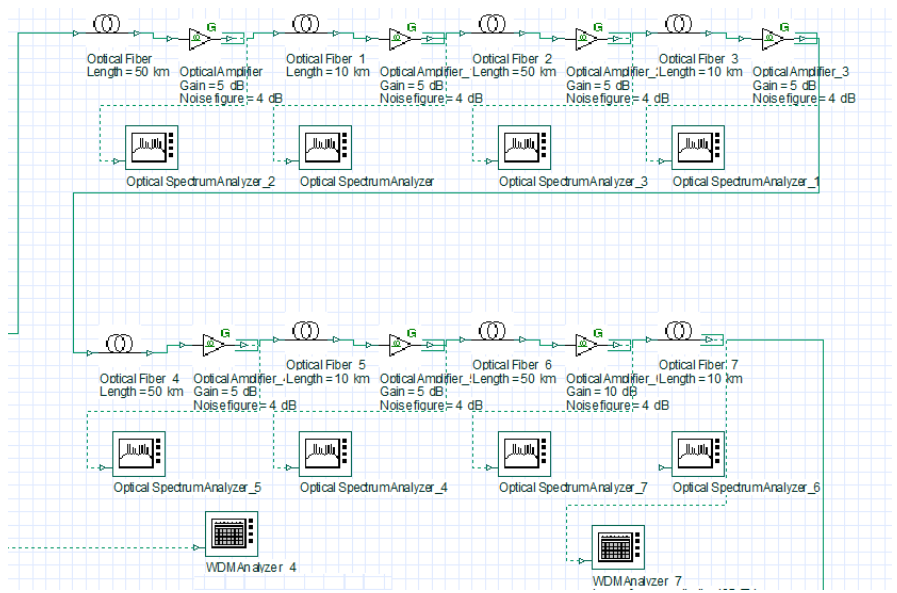
Figure 3. EDFA model in our DWDM system. Table 9. Results of 32-channel EDFA DWDM system.